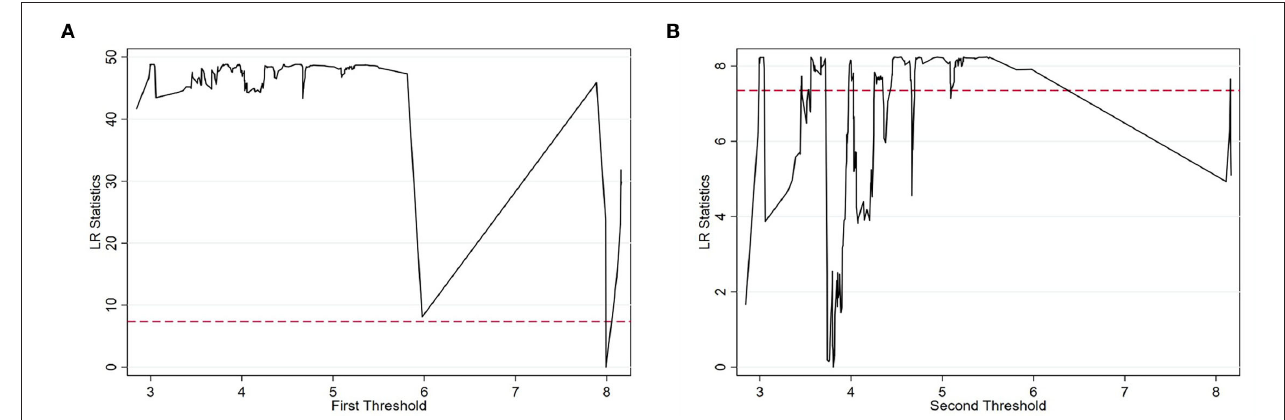
FIGURE 2 | LR Diagram with the threshold variable LnFert − intensity .